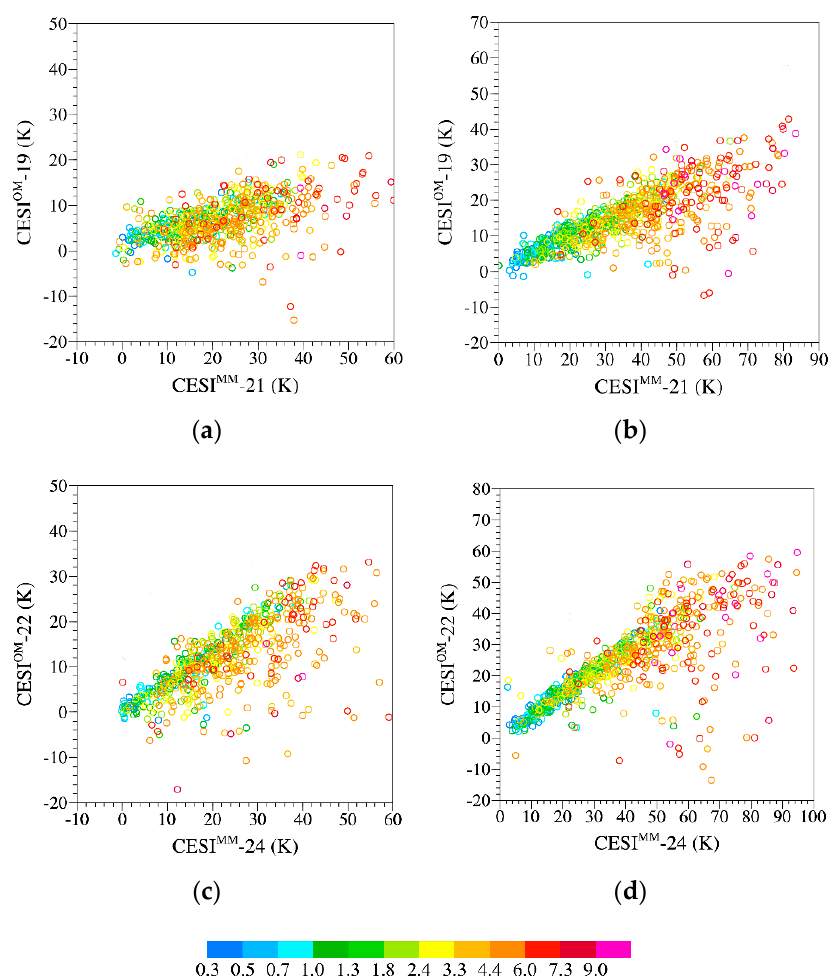
Figure 14. Scatter plots of ( a , b ) CESI MM -21 versus CESI OM -19 (~628 hPa) and ( c , d ) CESI MM -24 versus CESI OM -22 (~718 hPa) from the AIRS / HIRAS overlapping area at ascending nodes over domain 1 (left panels) and domain 2 (right panels) on 2 February 2019. The colors indicate AIRS ice cloud optical depth (Figure 12a).